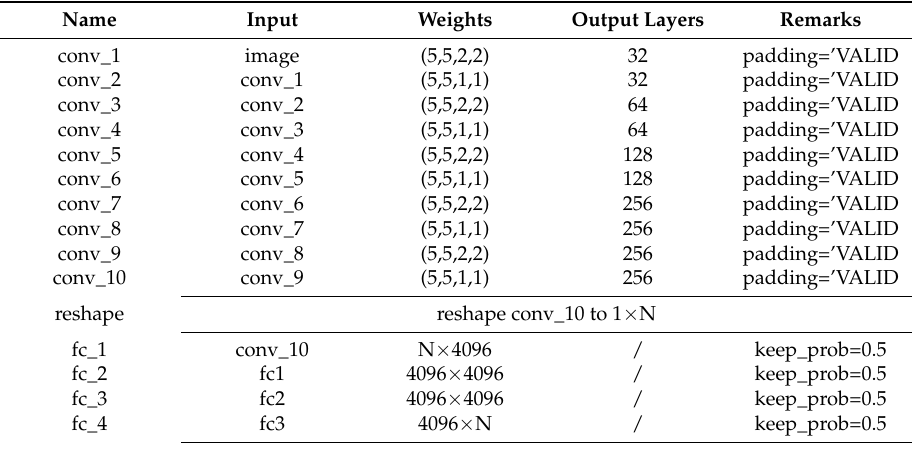
Figure 2. The architecture of our network. Conv is a convolution operation, and deconv is a deconvolution operation. Table 1. Details of our deep convolution neural network (DCNN). Conv is a convolution operation, and deconv is a deconvolution operation.